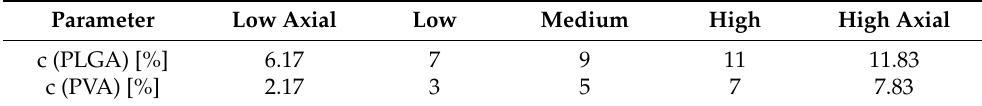
Table 5. Settings of central composite response surface